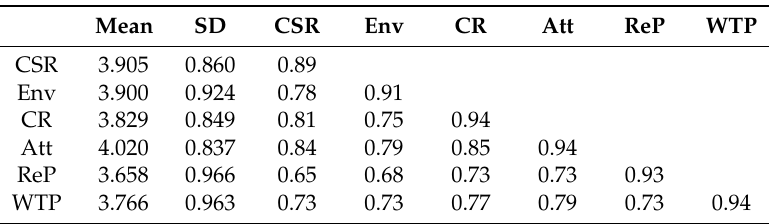
Table 2. Correlation matrix.